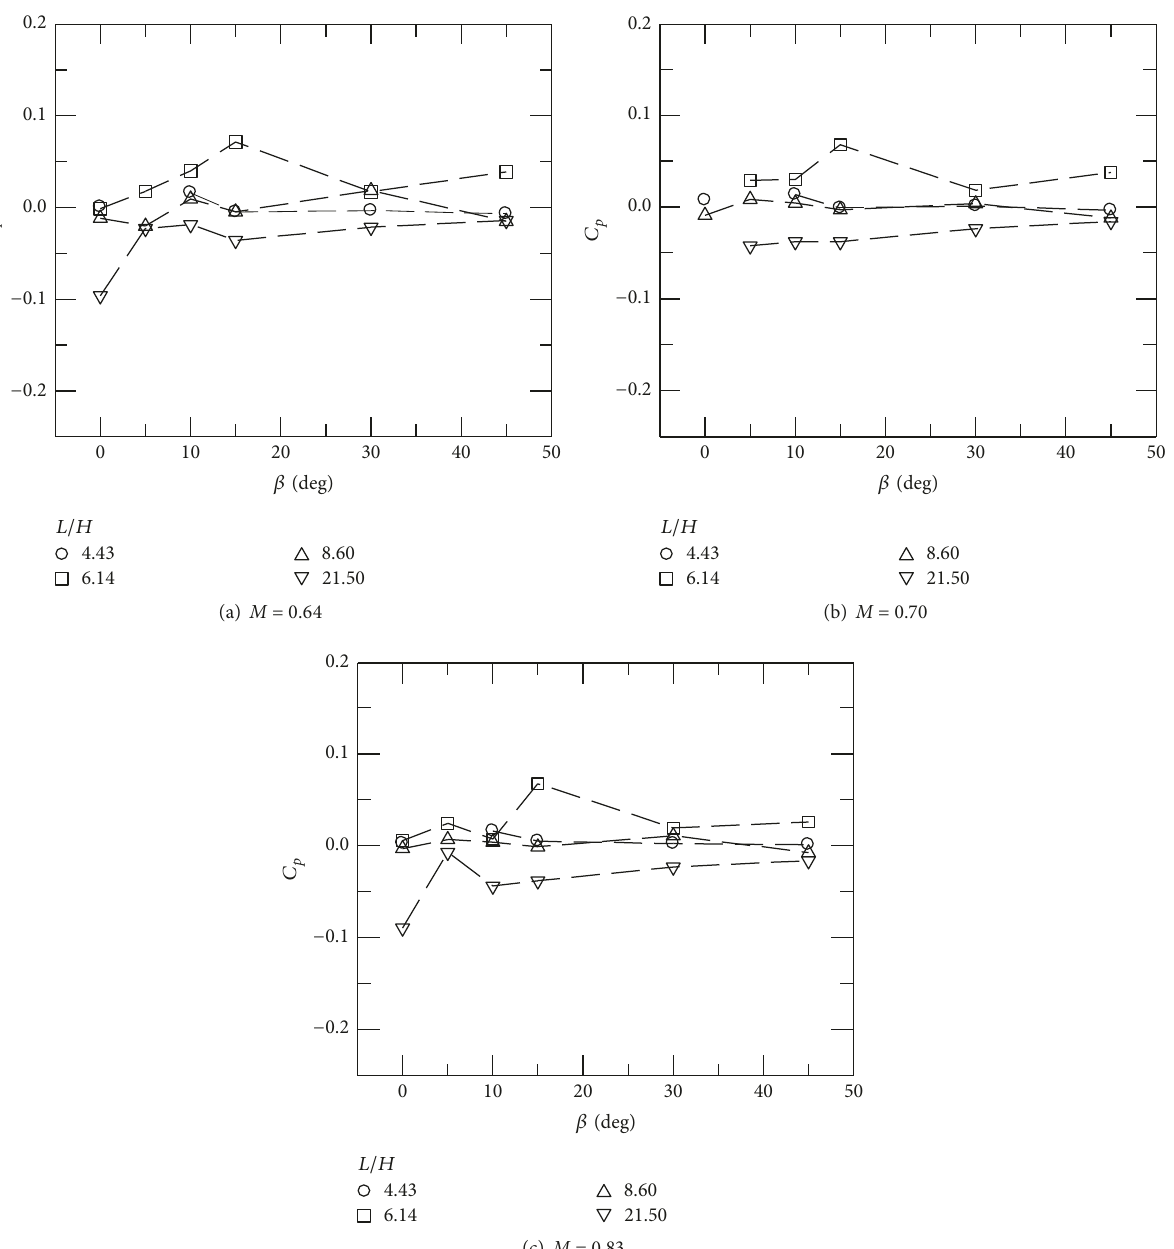
Figure 4: The pressure coefficient upstream of the cavity ( x/L = − 0.058): (a) M = 0.64, (b) M = 0.70, and (c) M = 0.83.